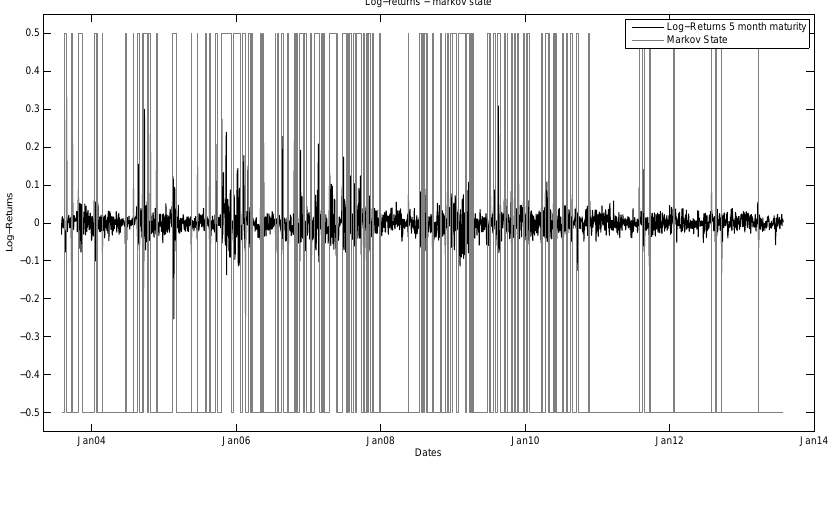
Figure 5. Fitted Markov chain.